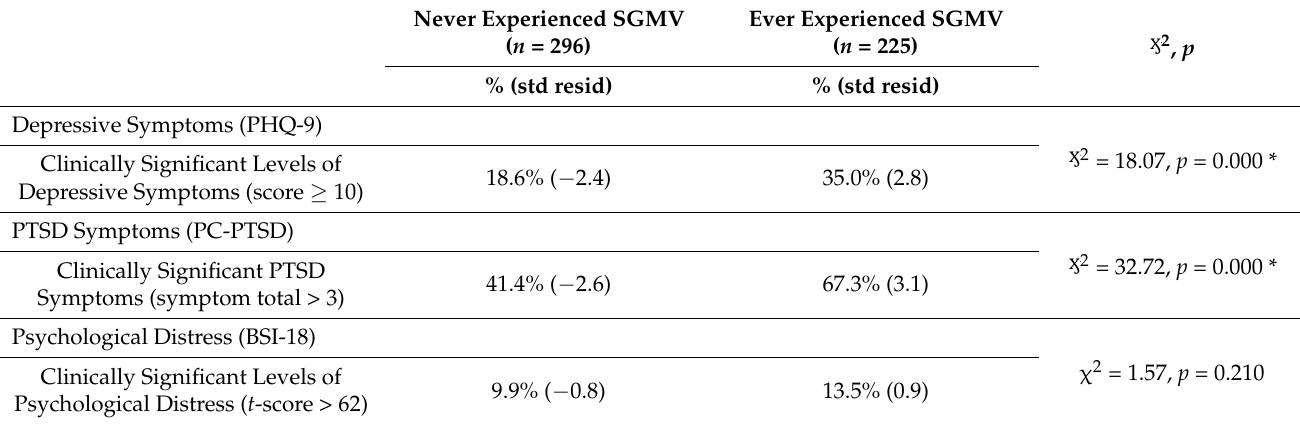
Table 4. Psychological Distress, PTSD Symptoms and Depressive Symptoms: Comparisons with Lifetime Experiences of Sexual/Gender Minority-Based Violence.